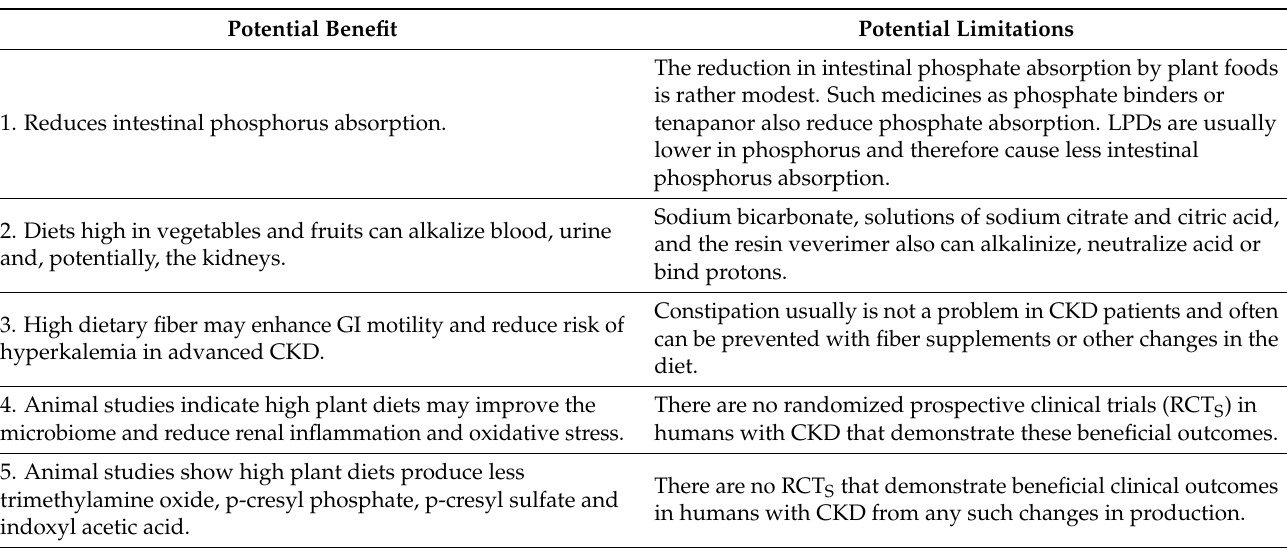
Table 3. Potential Benefits of High Plant Diets for People with